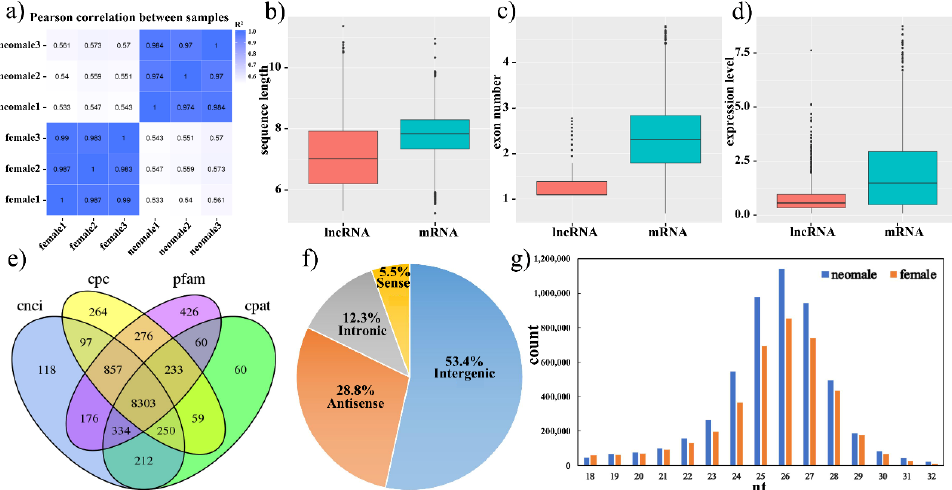
Figure 1. Characterization of mRNAs, lncRNAs and miRNAs in ovary and testis of gynogenetic P. olivaceus . ( a ) The Pearson coefficient from TPM values of gonad samples; ( b ) transcript length, ( c ) exon number, and ( d ) expression level between lncRNAs and mRNAs; ( e ) Venn diagram of lncRNAs identified with four methods; ( f ) the classification of lncRNAs; ( g ) length distribution of miRNAs.